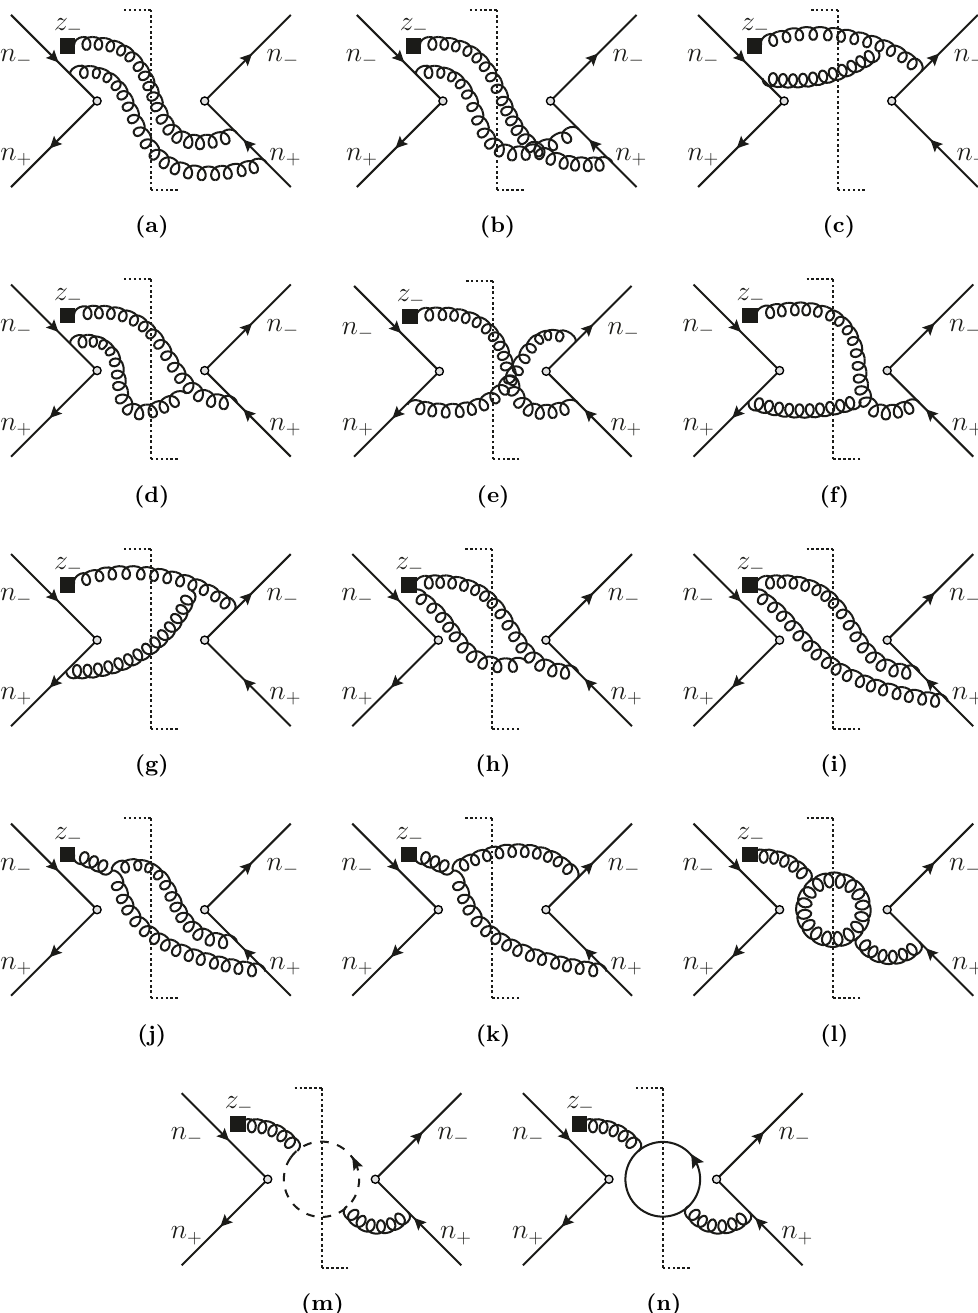
Figure 1. Diagrams contributing to the S 1 soft function. The part to the left (right) of the cut corresponds to the time-ordered (anti-time-ordered) part of the diagram, and lines labeled by n ± with in (out)-going arrow correspond to soft Wilson lines Y ∓ ( Y † stands for the soft covariant derivative and the Wilson lines contained in i∂ ⊥ µ